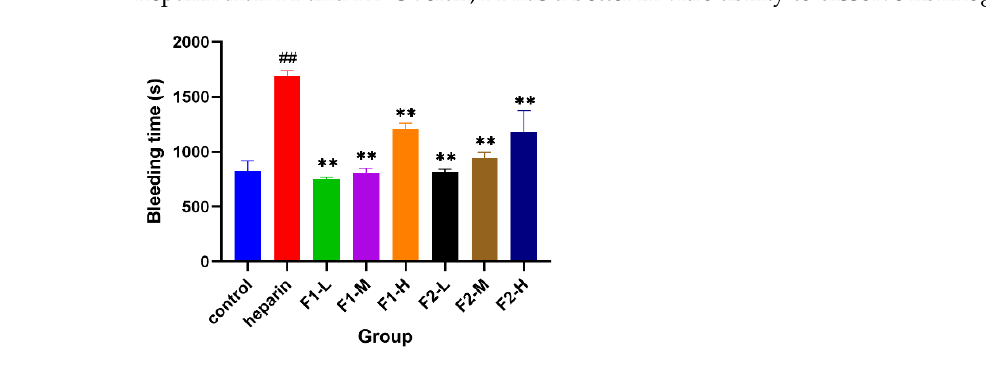
Figure 6. Bleeding effect of F1 and F2. ## p < 0.01 vs. control group; ** p < 0.01 vs. heparin group ( n = 6).